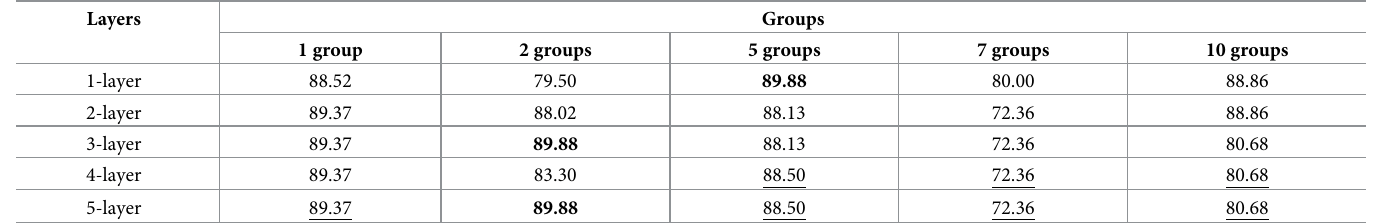
Table 9. Classification performance(%) at each layer where the roulette-wheel class is positive.